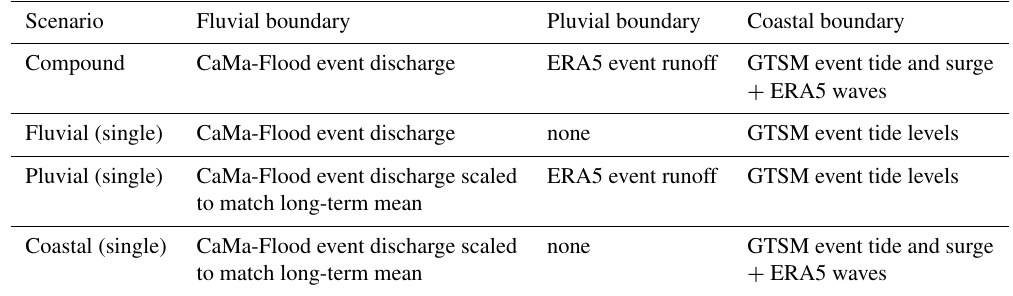
Table 3. Overview of model boundary conditions in compound- and single-driver